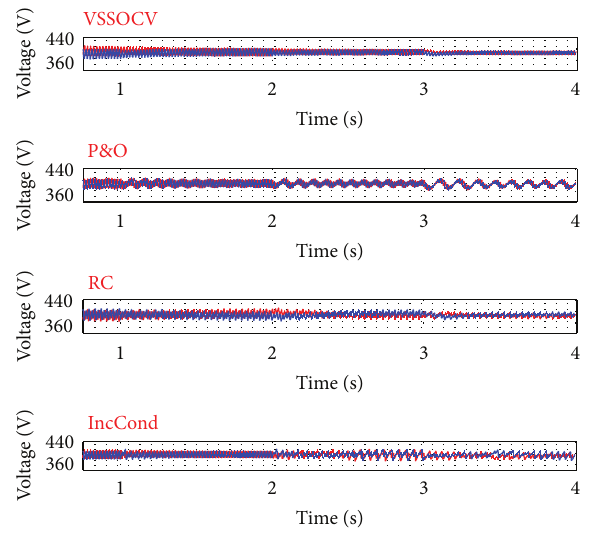
Figure 14: DC-link voltage with different